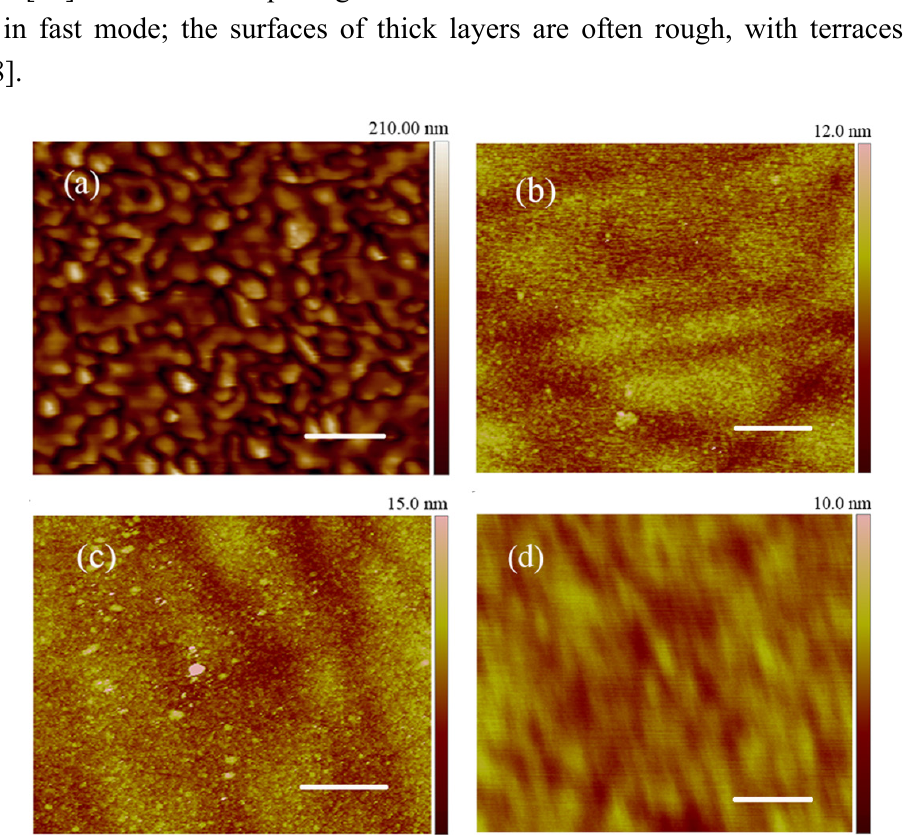
Figure 1. AFM morphologies of ( a ) NsiCL (Nano-textured 4H–SiC homoepitaxial layers), graphene ( b ) G-1h-1700K, ( c ) G-2h-1700K and ( d ) G-1h- 1900K. Scale bars: 2